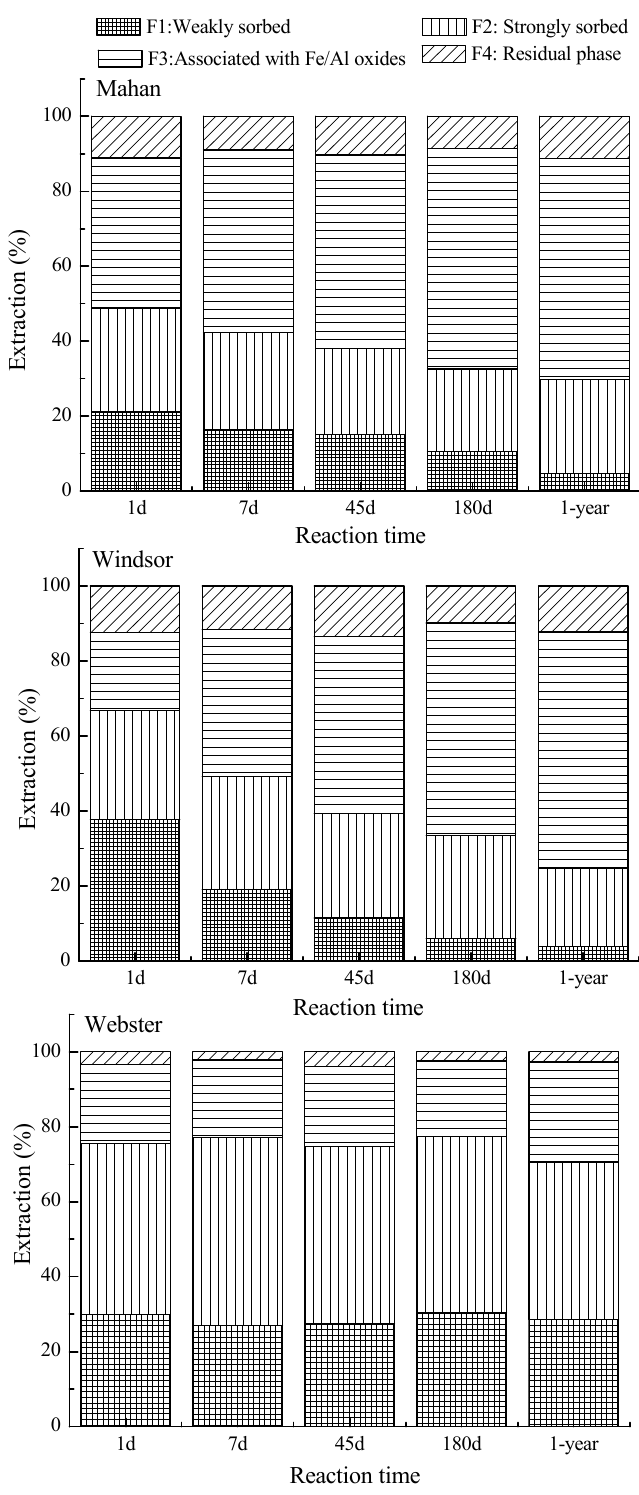
Figure 3. Distribution of molybdenum among retention phases Mahan, Windsor, and Webster soils as determined from sequential extraction. Different groups indicate different reaction time of 1 day, 7 days, 45 days, 180 days, and 1 year.